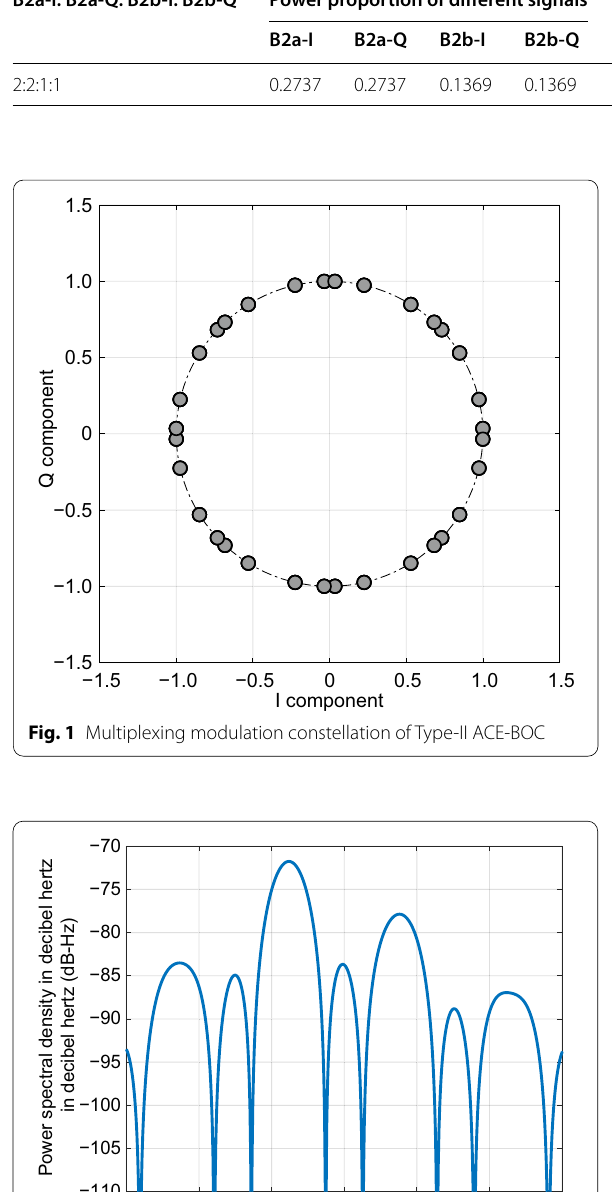
Table 1 Power proportion and multiplexing efficiency B2a‑I: B2a‑Q: B2b‑I: